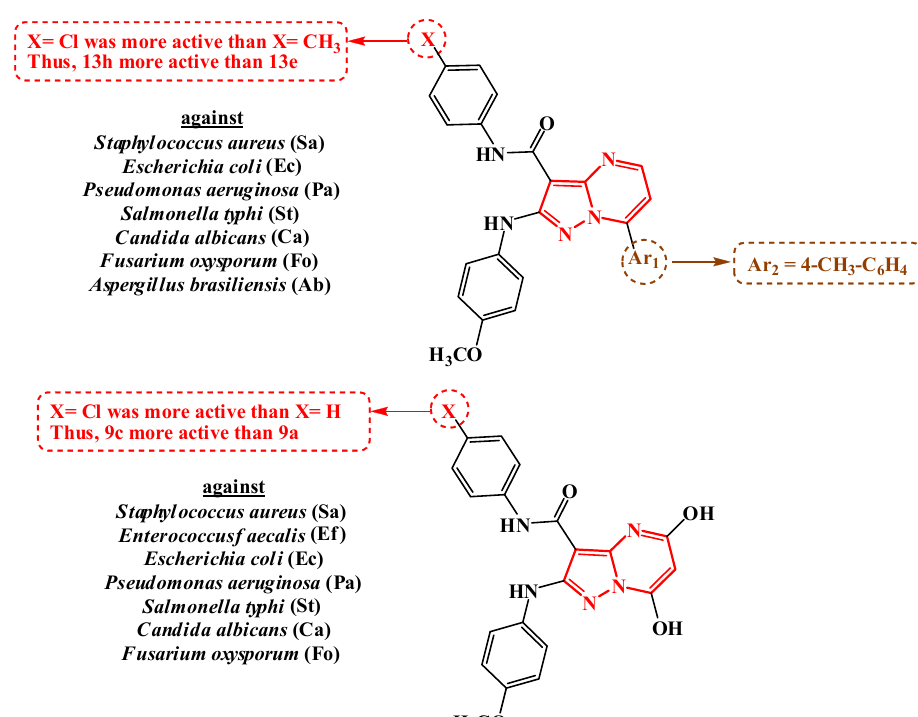
Figure 3. A brief structure–activity relationship (SAR) study of the active pyrazolopyrimidines. 2.4. Physicochemical, Pharmacokinetic, ADME, Toxicity Prediction and Drug-Likeness 2.4.1. Lipinski’s Rule of Five for Pyrazolo[1,5- a ]pyrimidines 5a – c , 9a – c and 13a – i To qualify 5,7-dimethylpyrazolo[1,5- a ]pyrimidines 5a – c , 5,7-dihydroxypyrazolo[1,5- a ]pyrimidines